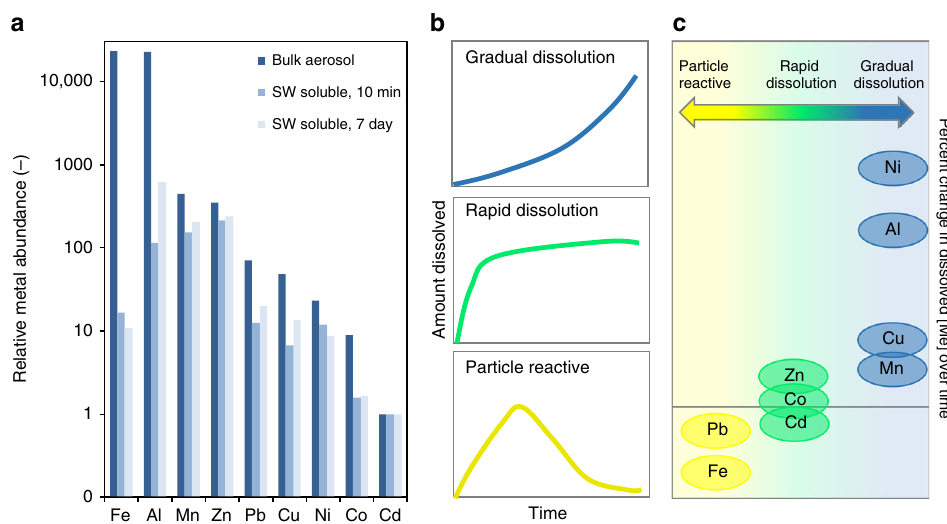
Fig. 5 Ocean dissolution processes. a Elemental molar fractions of metals in bulk aerosol material collected In Eilat, Israel along the coast of the Gulf of Aqaba, Red Sea, and in the sea water-soluble fractions after 10 min and 7 days of leaching. Metals are arranged from most to least abundant based on the abundance in the bulk aerosol. Data were published previously in Mackey et al. 74 ; see reference for sample collection and methodological details. b Three dissolution modes were observed for different metals. Gradually dissolving metals show increased dissolved concentrations over time, whereas nearly all soluble metal is released immediately for rapidly dissolving metals. For particle reactive metals, the dissolved concentrations fi rst increase but then decrease due to sorption onto particles and/or wall loss. c Schematic of the percent change in soluble concentration of several aerosol metals over time based on measurements after 10 min and 7 days of leaching. Positive values (above the horizontal line) indicate more metal dissolves with longer leaching (gradual dissolution), while negative values (below the horizontal line) indicate declining concentrations with time (particle reactive). Values near zero indicate rapid dissolution where the concentration of dissolved metal remains relatively constant over